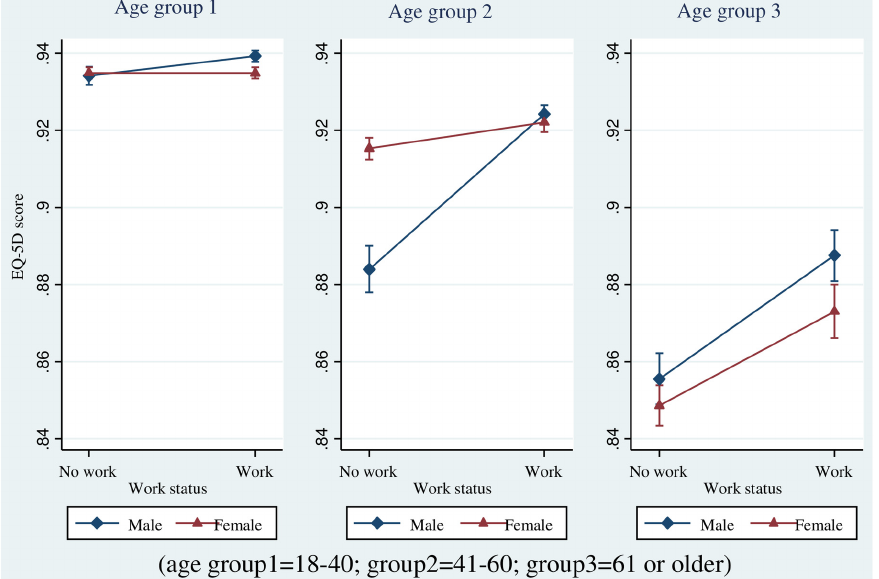
Fig 2. Relationship between quality of life and work status by gender by age